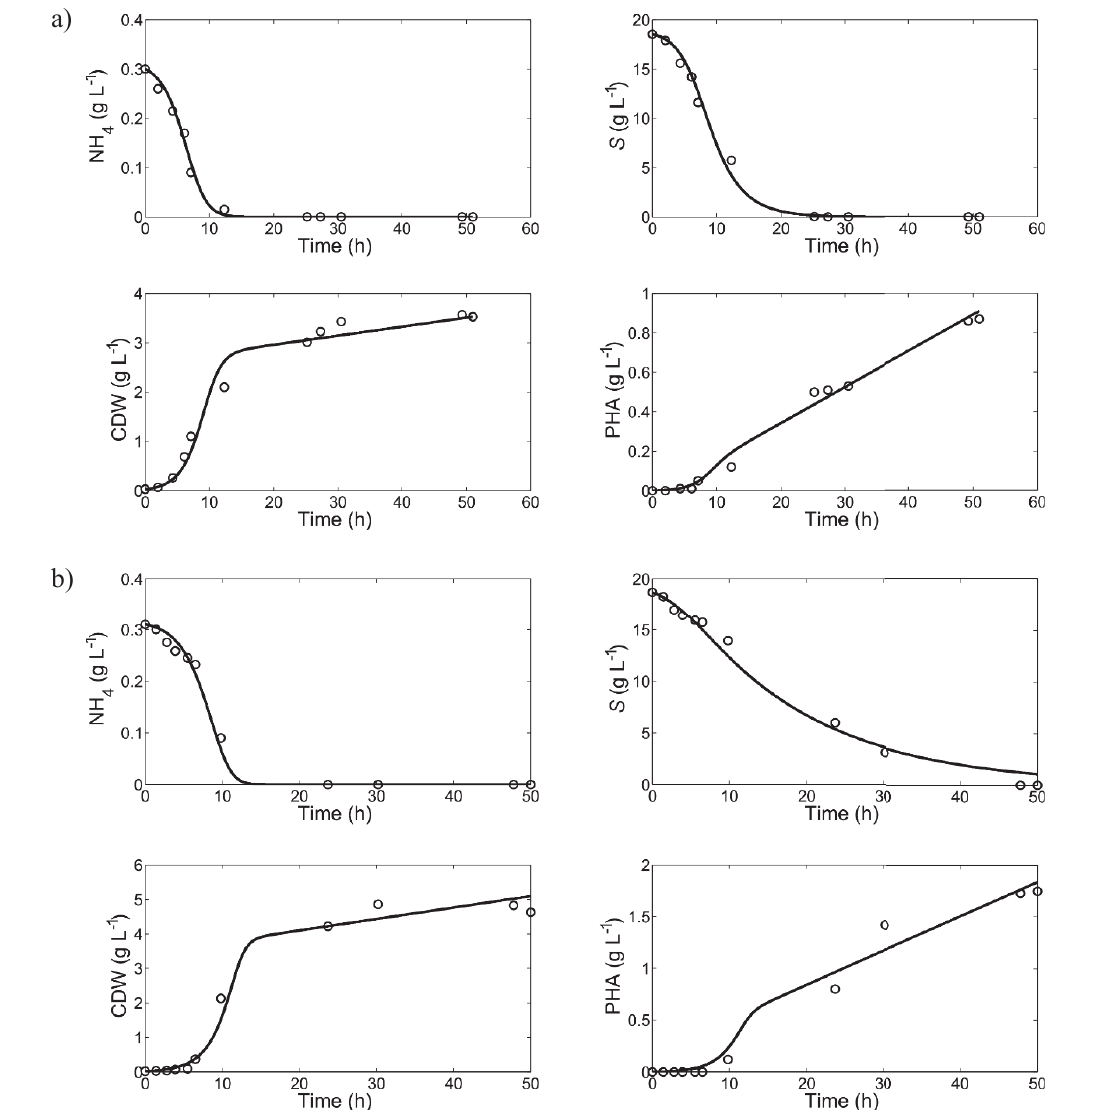
Fig. 4 – Simulation results. The results are displayed, a) for wild strain, and b) for mutant strain. The simulations were developed using parameter values from Table 1. Confidence intervals were calculated using the Weighted Bootstrap method 25 . Results